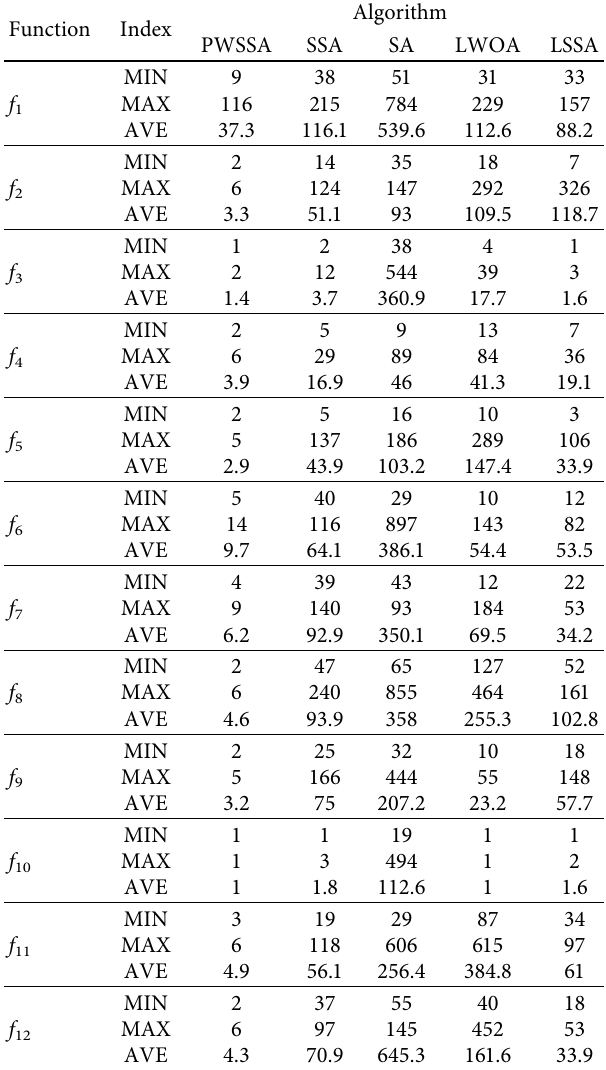
Table 5: Comparison of the number of running times. Function Index